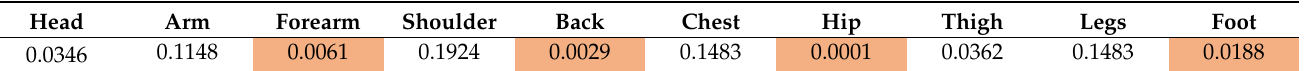
Table 14. p -value of the thermal